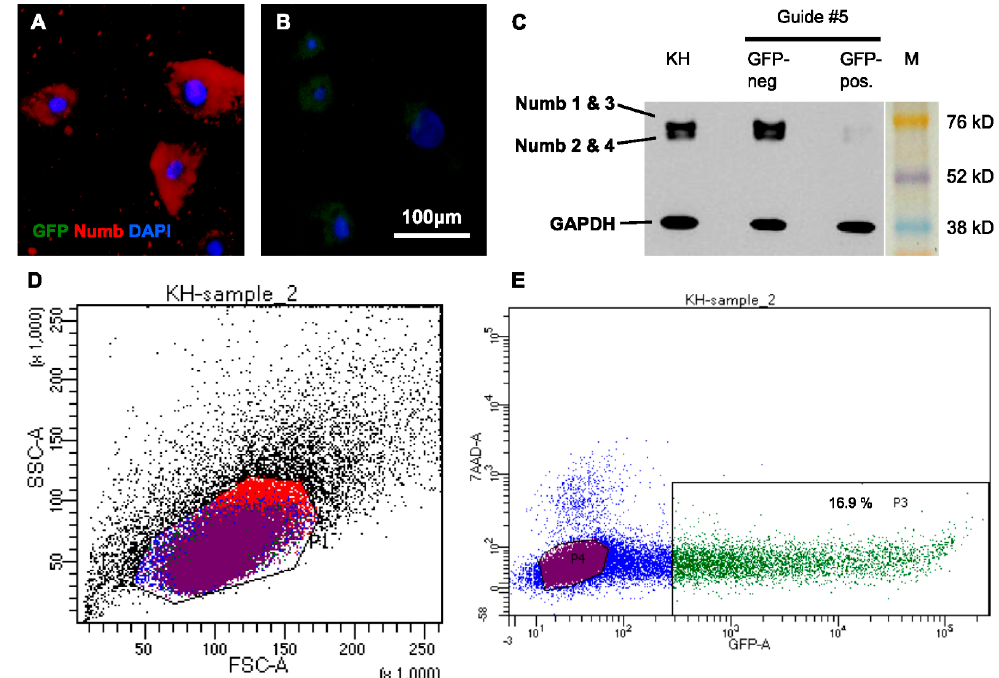
Figure 5. Numb is stably knocked down in human keratinocytes by CRISPR/Cas9. NHEK cells were transfected with plasmids carrying Cas9 and different gRNAs. Due to co-expression of GFP, successfully transfected cells were collected by FACS and reseeded. ( A ) After two weeks of cultivation, Numb protein was abundantly detected in sorted, GFP-negative cells, while ( B ) no protein was detected in the GFP-positive (knockdown) fraction; ( C ) The efficient knockdown of Numb in all of its isoforms was confirmed by Western Blot analysis of lysates of these cells and skin (KH) for comparison; ( D ) FACS revealed that the transfected cells were largely viable; ( E ) Between 12% and 20% of the transfected cells had taken up the CRISPR/Cas9-construct and were GFP positive in seven individual experiments. Gating: All cells (black), Live, 7AAD-negative cells (blue), GFP-neagtive (purple), GFP-positive (green), cells gated out in FFS/SSC (red). GFP: Green fluorescent protein; DAPI: 4 ′ ,6-Diamidin-2-phenylindol; KH: human keratinocytes; M: Marker; GAPDH: Glyceraldehyde-3-Phosphate Dehydrogenase; FSC: Forward scatter; SSC: Side scatter; 7AAD: 7-aminoactinomycin D.